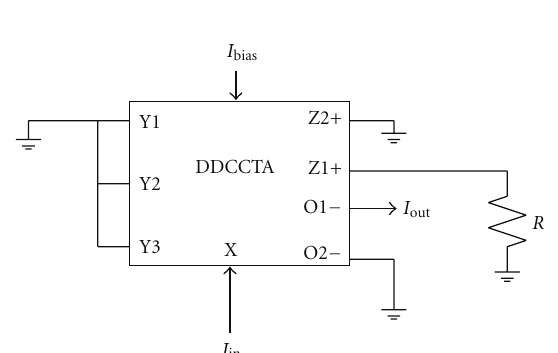
Figure 12: Voltage amplifier.